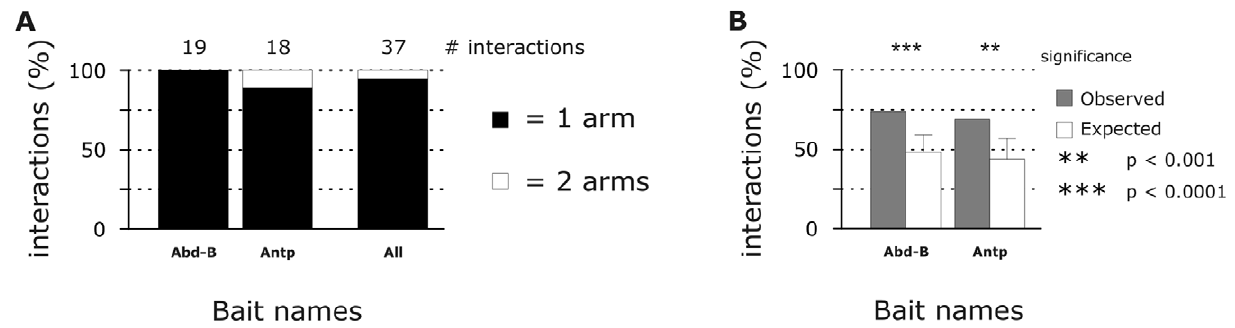
Figure 8. On the inverted third chromosome Homeotic genes preferentially contact PcDs located on the same chromosome arm. (A) Bar plots show quantification of interactions within single chromosome arm and between two chromosome arms in brain tissue from In(3LR)sep larvae. Plot is described in Figure 6B. Like on the wild type third chromosome (Figure 6B), on the inverted third chromosome 95% of all interactions are intrachromosomal and only 5% is interchromosomal. (B) Proportion of DIDs that overlap with PcDs. Plot is described in Figure 3A.